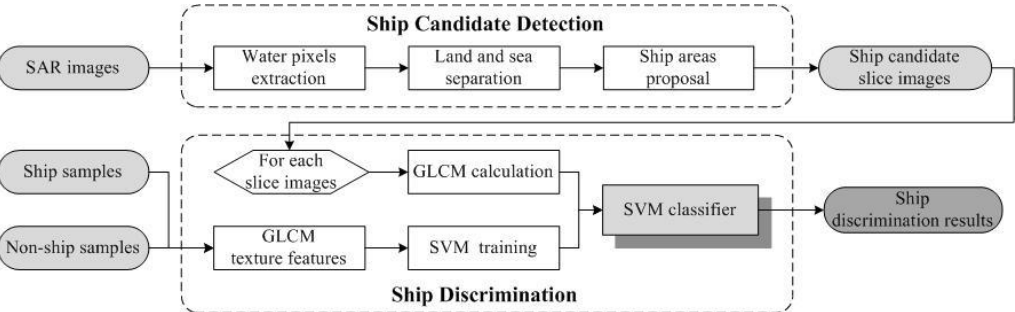
Fig. 1 Schematic flowchart illustrating the ship discrimination method adopted in the present study.